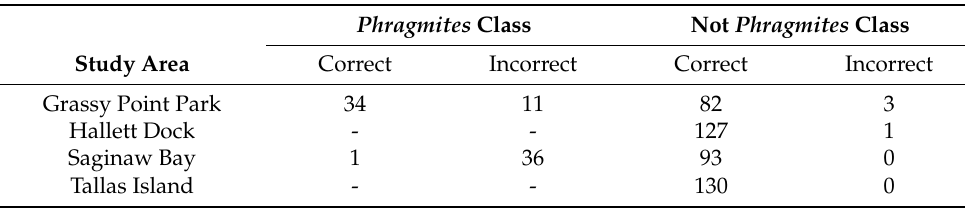
Table 7. Validated assessment points from each study area for the classification using the RGB UAS imagery and a UAS-derived CHM. Points are split by class ( Phragmites , Not Phragmites ) and if they were correctly identified (Correct,